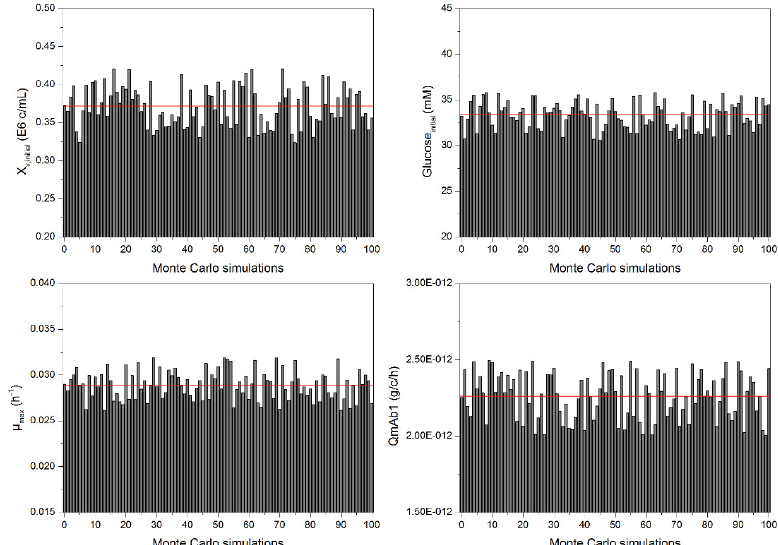
Figure 5. Example of the distribution of model parameters, resulting from 100 Monte Carlo simulations, varying each parameter equally distributed based on their experimental error. The horizontal line depicts the arithmetic mean of each parameter.